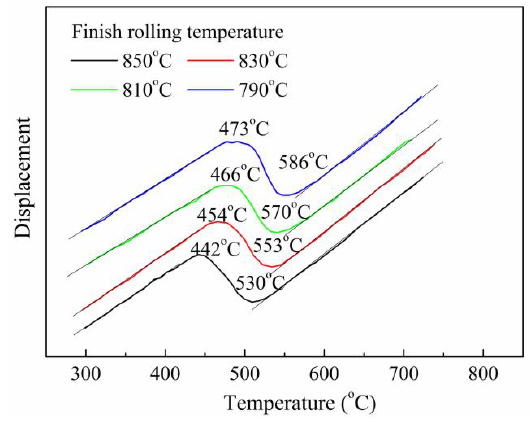
Figure 2. Expansion curves and Ar3 and Ar1 points for the samples with different finish rolling temperatures of 850–790 °C and an identical cooling rate of 15 °C/s.